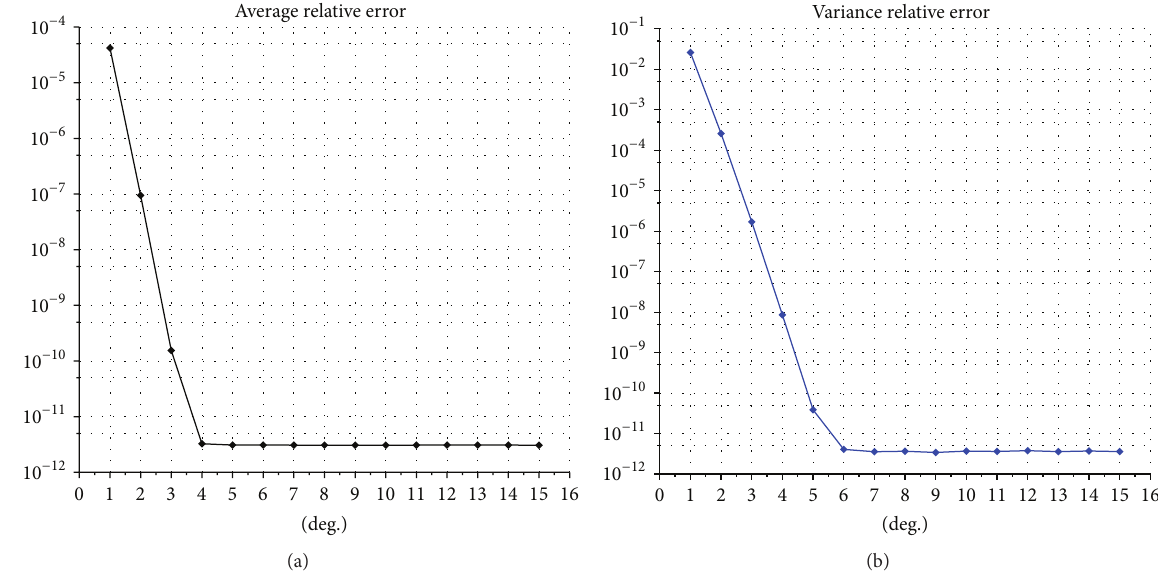
Figure 6: Semilogy scale plot for the absolute value of the relative error of the mean (a) and variance (b) computed via PCE of GBM at time 𝑇 = 1 (whose parameters are 𝑟 = 3 %, 𝜎 = 15 %, and starting value 𝑆